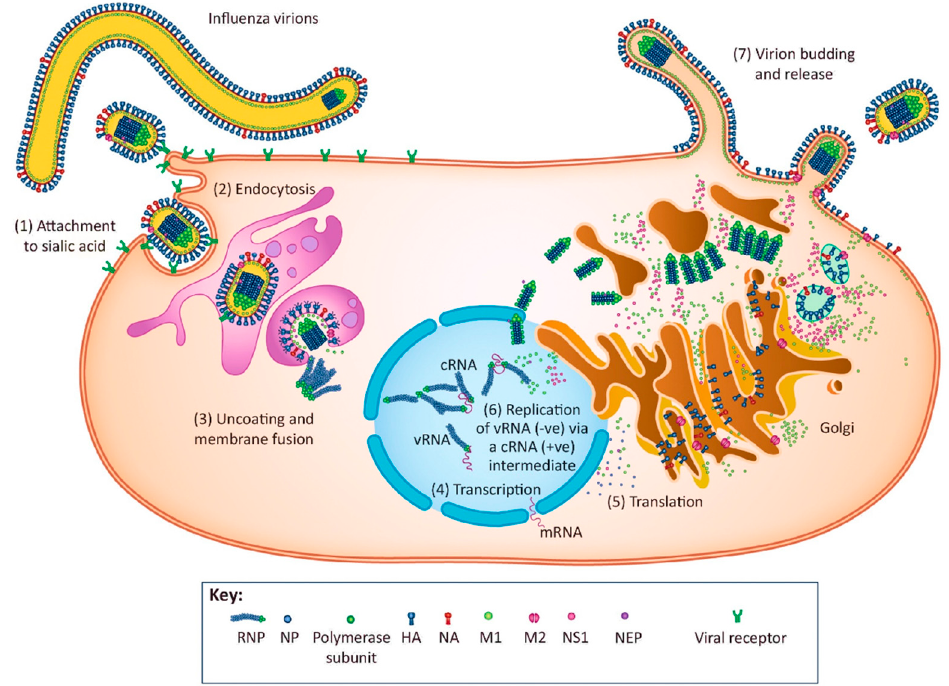
Figure 2. The replication cycle of influenza virus, illustrating seven discernible phases: (1) attach- ment; (2) endocytosis; (3) uncoating and membrane fusion; (4) transcription of the viral RNA; (5) translation of viral proteins; (6) replication of the viral RNA; and (7) virion budding and release